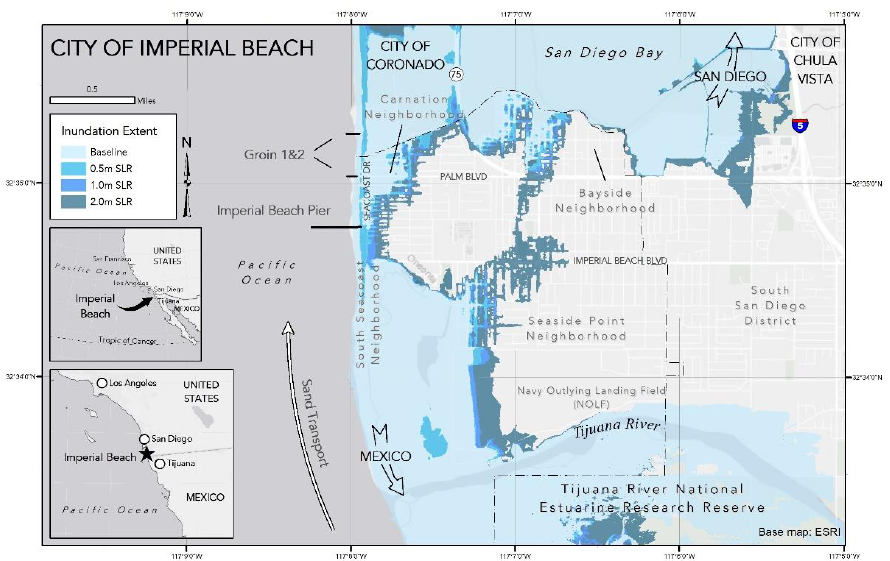
Figure 2. Case Study site of Imperial Beach in California, USA. Coastal hazard extents combined USGS CoSMoS 1.0, 3.0 Preliminary, and Department of Defense—SPAWAR.